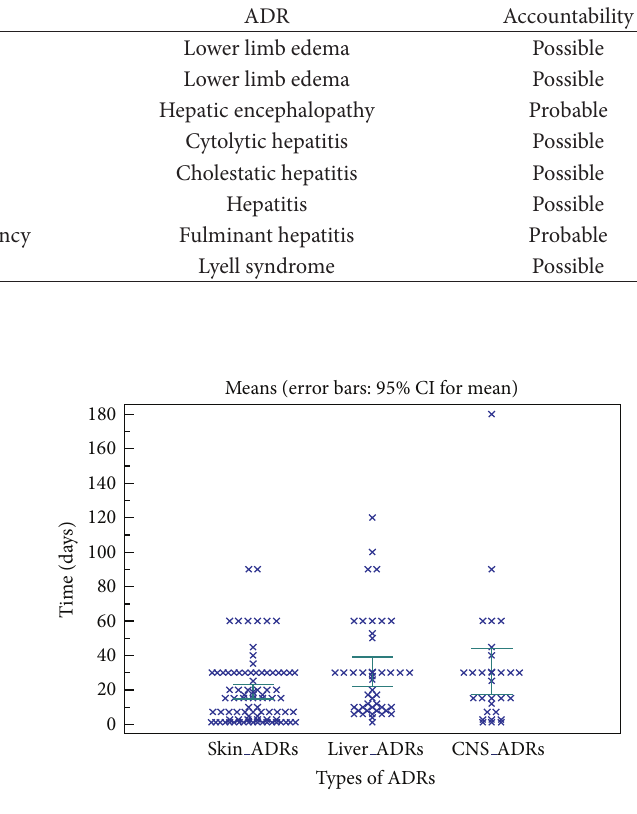
Figure 1: Comparison of average times to onset of cutaneous, hepatic, and neurological